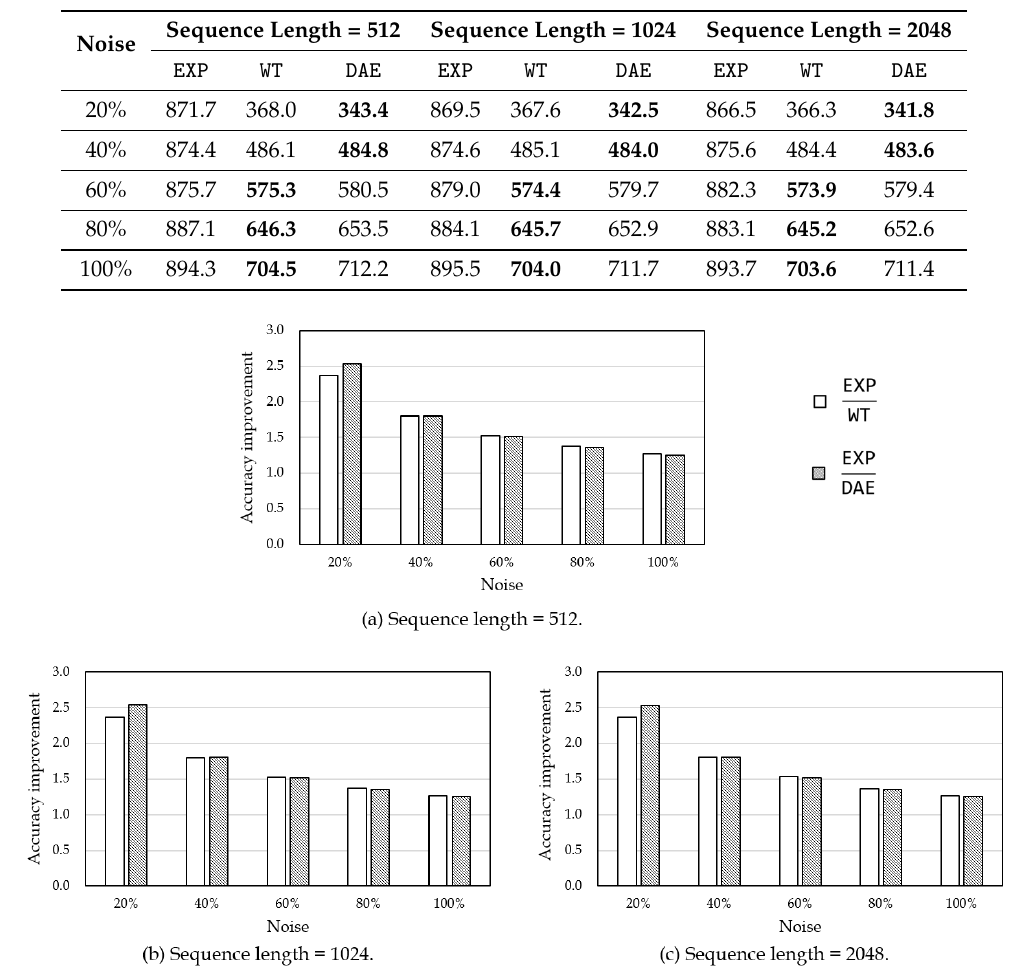
Figure 9. Filtering accuracy improvement on power data of different sequence